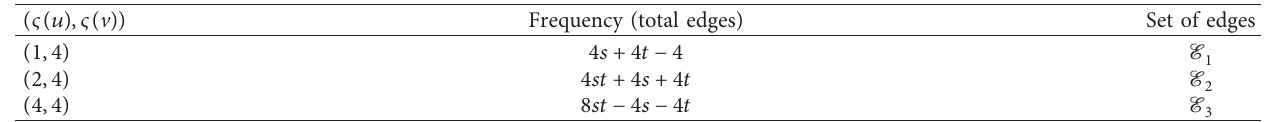
Figure 2: (a) Synthesis of InP QDs based on the method adopted from [23]. With applications (b) graph representing highest PL intensity [23]. (c) Graph representing highest PL/EL intensity [24]. (d) Graph representing the intensity of fluorescence and absorbance [25]. Table 1: Edge partition of InP [ s , t ] based on degrees of end vertices.